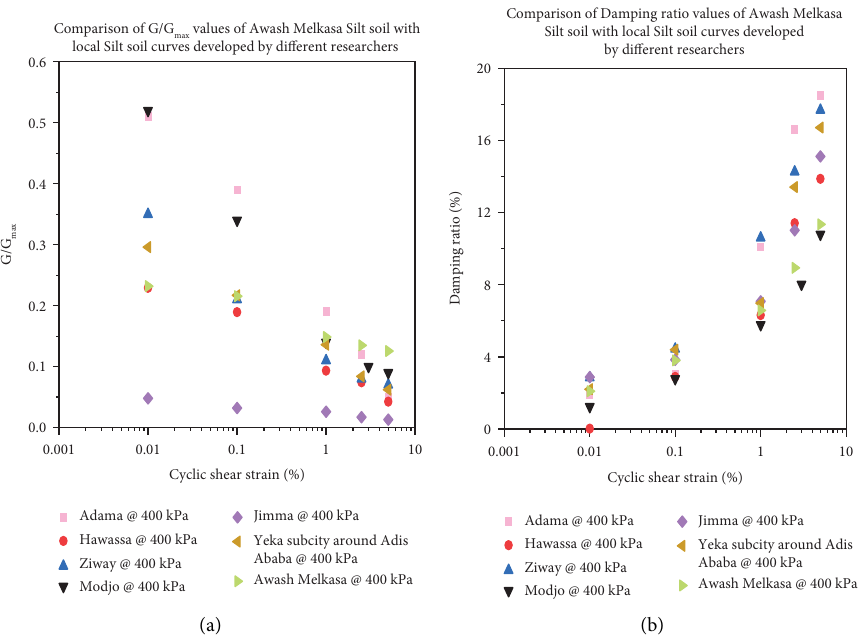
Figure 15: Comparison of Awash Melkasa silt soil with local silt soil curves developed by diferent local researchers: (a) G / G (b) damping ratio values [22,